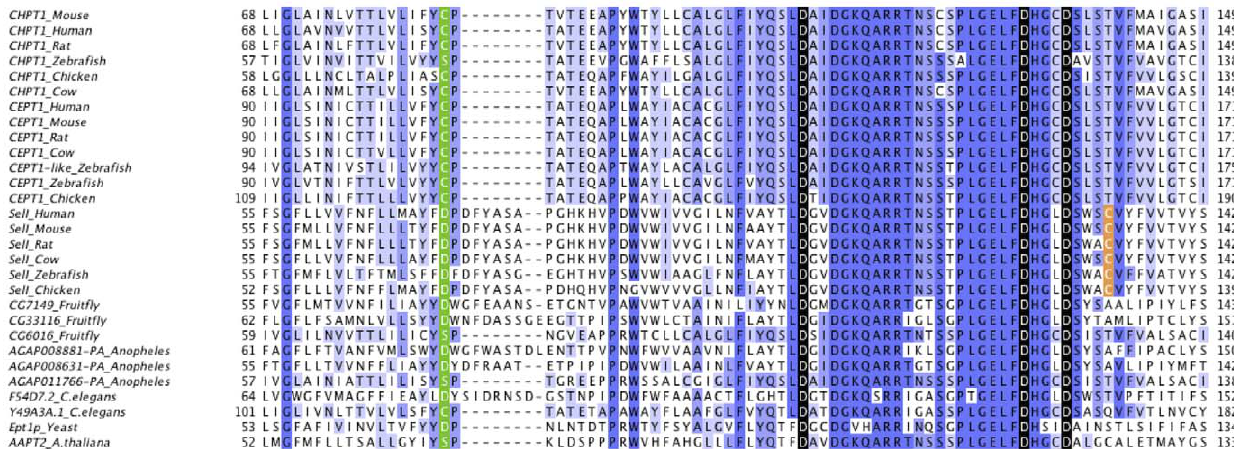
Figure 5. Multiple sequence alignment of SelI and its homologs. The multiple sequence alignment of the active site and preceding regions of CHPT1, CEPT1, and SelI is shown. Homologs are labeled with the annotated name. Proteins in the bottom section comprise a large group of diverse proteins containing the same domain. The most critical residues are marked in red. The residue in green marks the end of the first transmembrane domain. The cysteine residue near the active site emerged specifically in SelI proteins is marked in orange.The full length alignment is provided in Supplementary Figure S37 and the corresponding phylogenetic tree in Supplementary Figure S38.